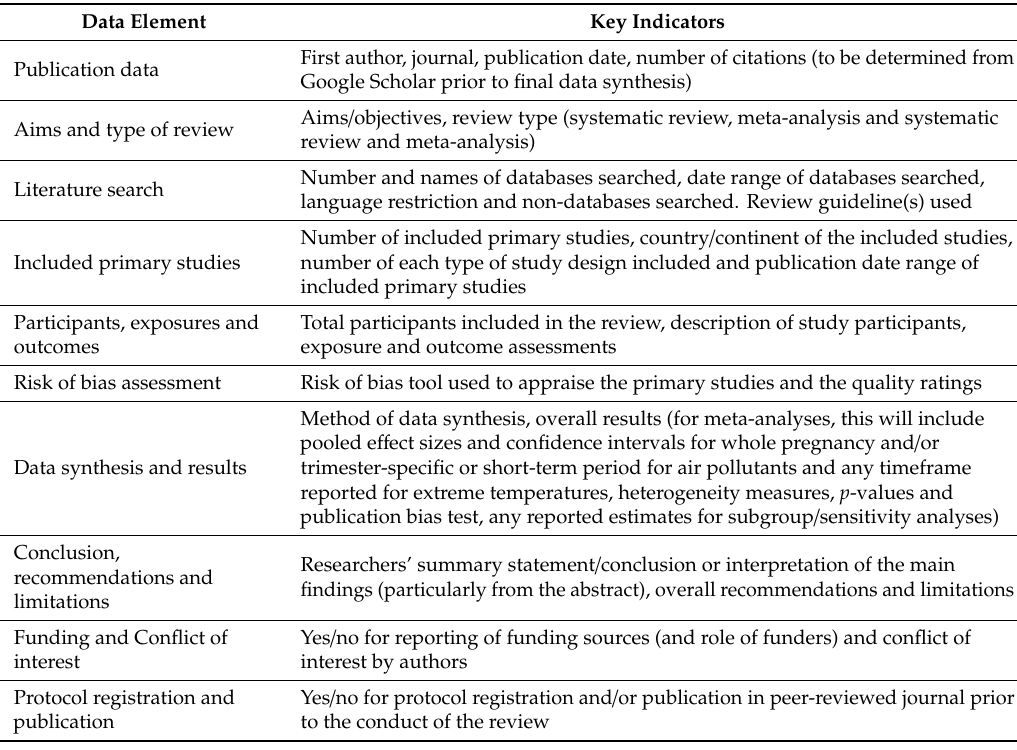
Table 1. Key data extraction elements for Systematic Review 1 (umbrella review).